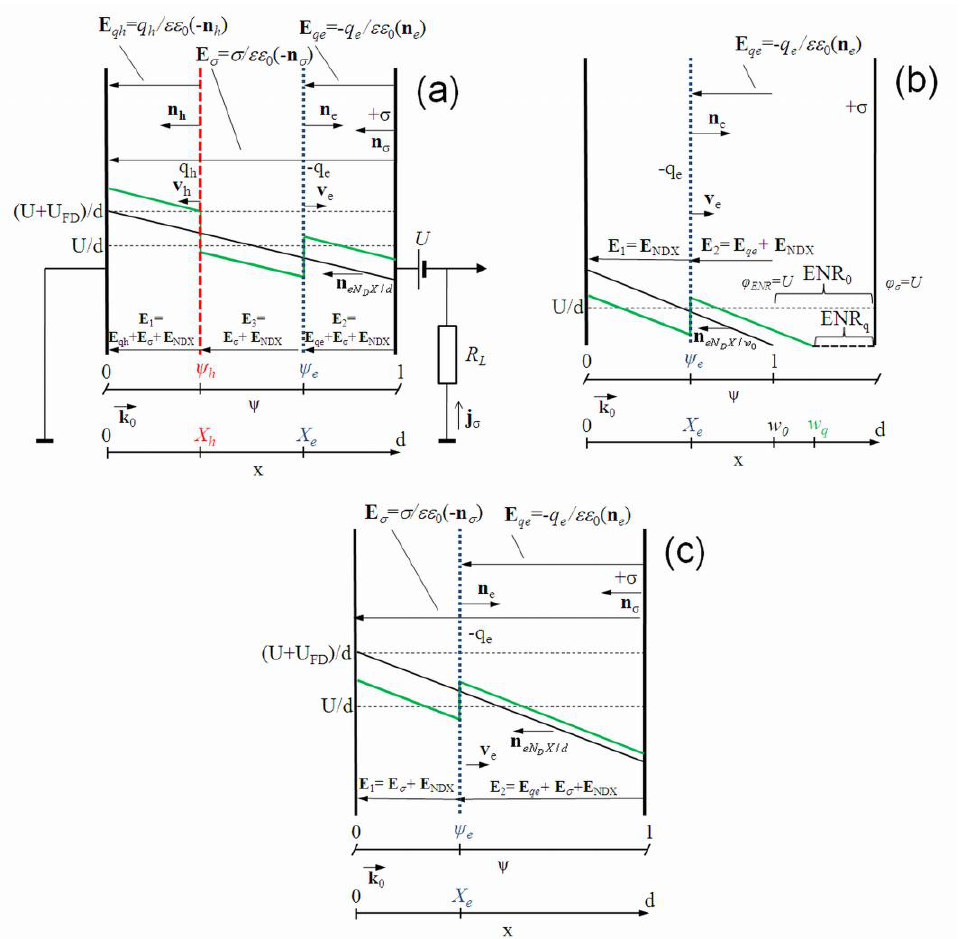
Figure 1. ( a ) Sketch of circuit for analysis of ICDC transients. Symbols denote as follows: X is the instantaneous position of the drifting one-sided surface charge domain of the e , h electrons (– q ) or holes ( q ) (with normal vectors n and n ), respectively; E = E + E + E e h e h 1 qh σ NDX is the electric field caused by the superposition of the hole charge ( q ) domain, the surface h (of an area S ) charge (+ σ , with a normal vector n ) on the high potential electrode and the σ local surface charge introduced to represent the electric field at x created by a bar (of a width ( d−x )) of the bulk ion charge (with a normal vector n ); E = E + E + E is eNDX 2 qe σ NDX the electric field caused by the superposition of the electron charge (– q ) domain, the e surface charge (+ σ ) and the local surface charge of the ion bar; E = E + E is the 3 σ NDX superposition of field between the electron and hole domains and the surface charge of the ion bar; v is the instantaneous velocity vector of a drift of the surface charge domain – q e,h e or q , respectively; d is the inter-electrode distance;  and  are the material and vacuum h 0 dielectric permittivity, respectively; k is the unit ortho-vector in the uni-directional 0 coordinate system; ψ and ψ are the dimensionless, normalized positions of the drifting h e hole or electron domains, respectively; j is the current density; U is the external source of σ voltage; R is the load resistor. The sketches are illustrated for the electric field L instantaneous distribution due to the injected negative charge surface domain within a partially depleted ( b ) and fully depleted junction ( c ), respectively. w is the steady-state 0 depletion width; w (t) is the charge drift introduced depletion q